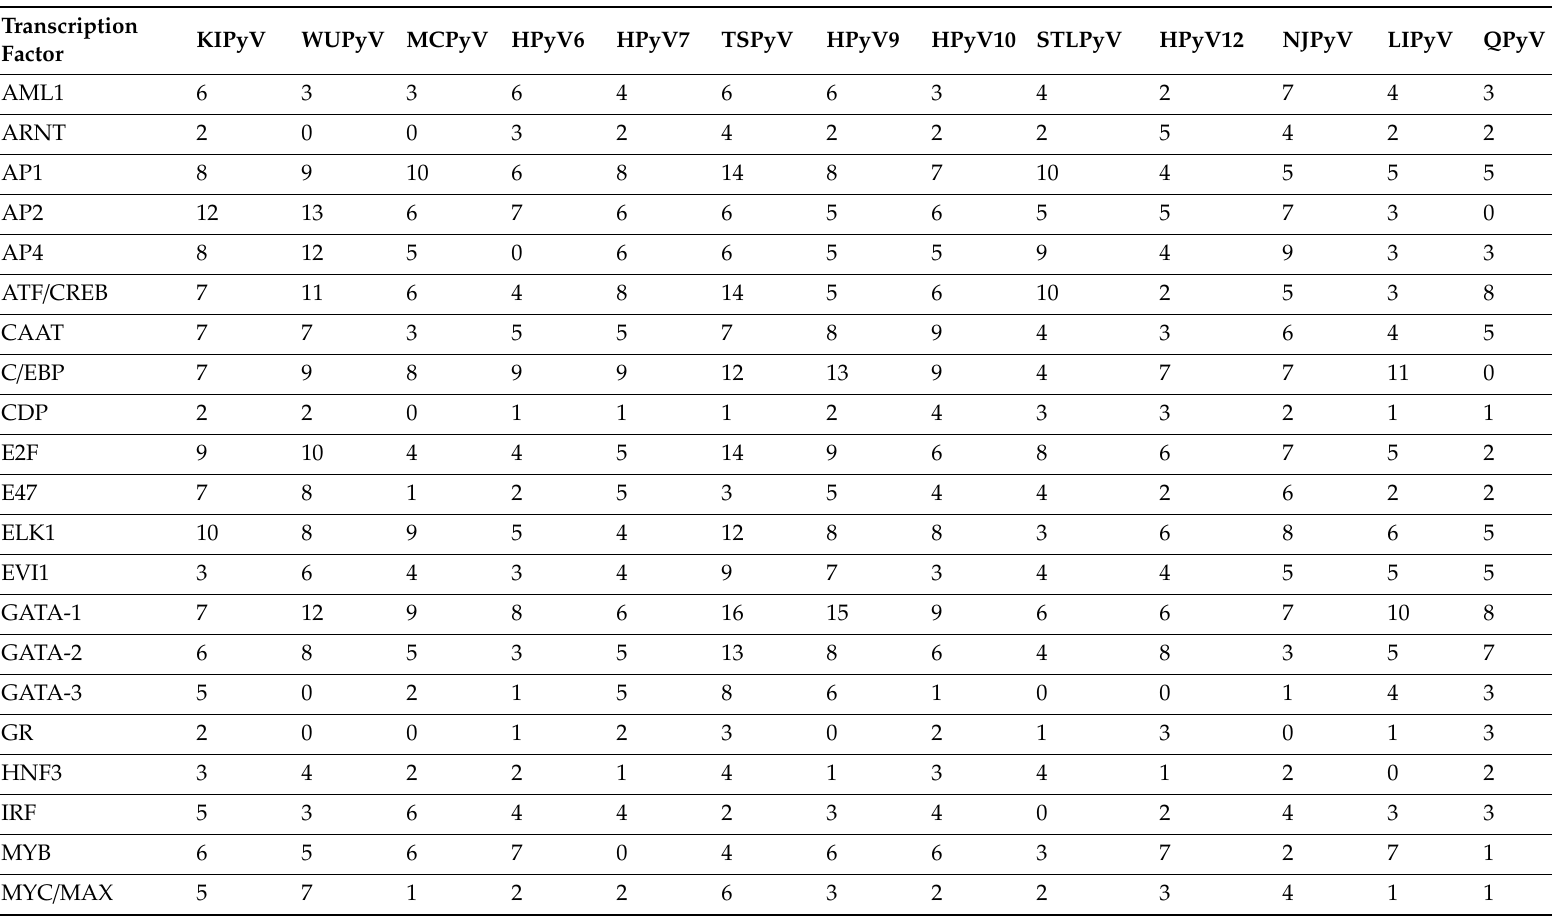
Table 4. Number of putative transcription factor binding sites in the noncoding control region of the novel human polyomaviruses. Prediction based on TFBIND tool